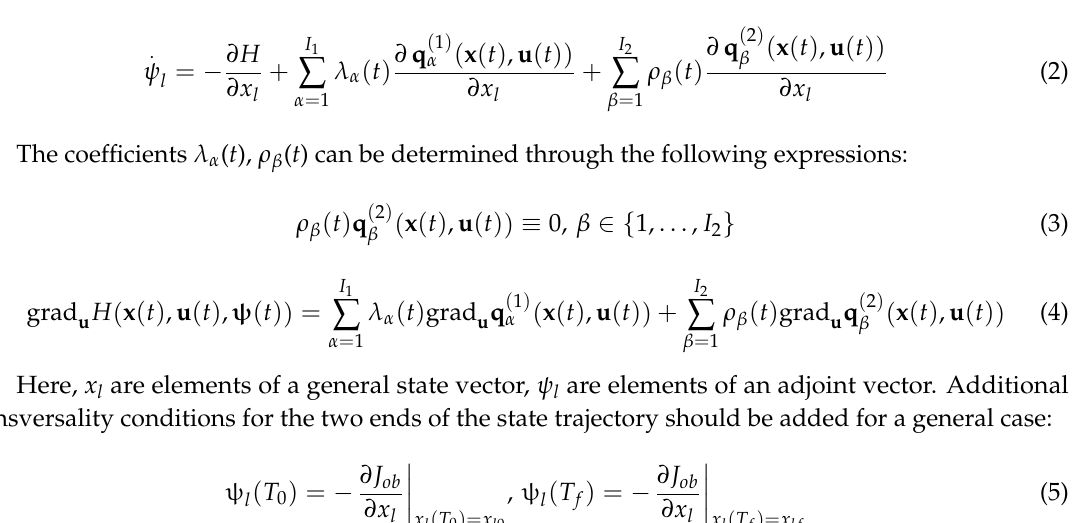
from the initial state to the specified final state. If